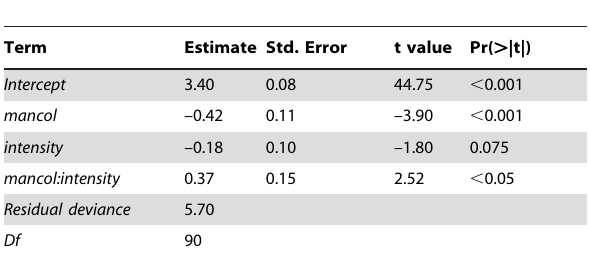
Table 4. PERMDISP tests of homogeneity of dispersions (functional similarity) results based on mean distance to group centroid for all groups within each factor, using log(x + 1) transformed functional group density data.